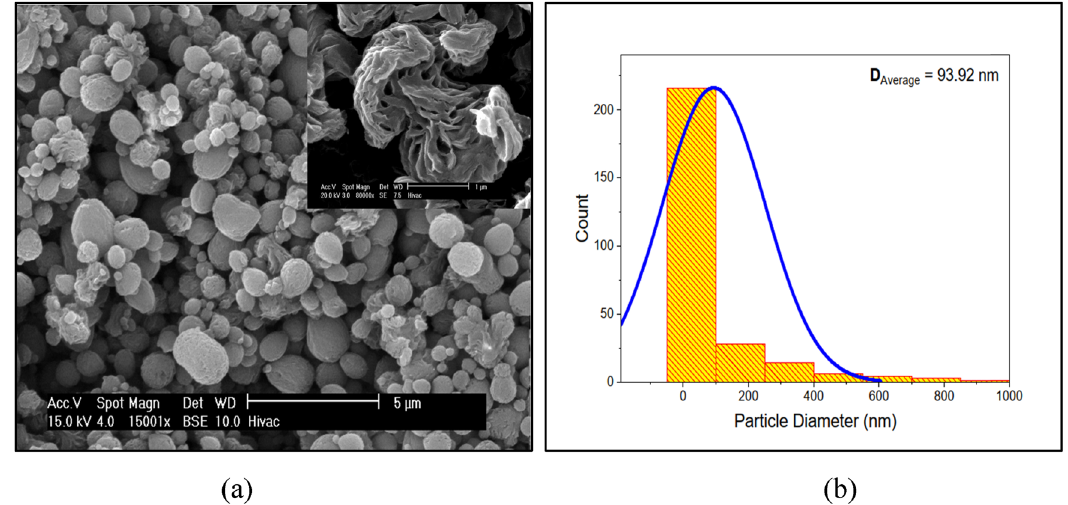
Figure 5: ( a ) SEM micrograph of nylon 66 spherulite ( 41 ) . ( b ) Nylon 66 crystallites ’ ( grains ) diameter distribution curve.